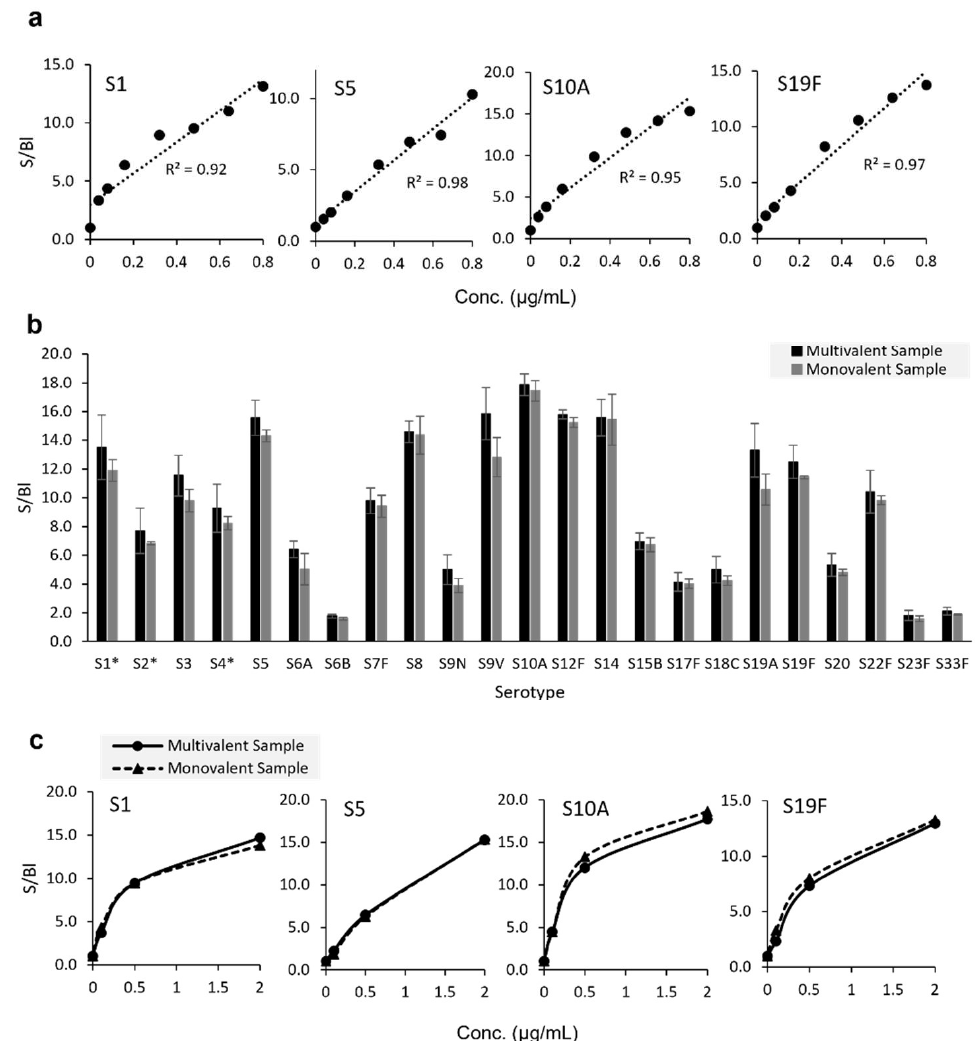
Figure 3. Signal response curves and comparison of response curves for monovalent vs. multivalent analyses. ( a ) Eight-point response curves generated for monovalent native S1, S5, S10A, and S19F labeled using 23-Mix Primary Detection Label. R2 is based on single linear fit (dotted line). ( b ) Signal-to-blank (S/Bl) ratios generated using native PS (ATCC, deposited by Pfizer) at 0.8 µg/mL in contrived 23-valent native polysaccharide mixture and in monovalent form detected by 23-Mix Primary Detection Label. Error bars indicate one standard deviation (n = 3), *: S1, S2, and S4 data are from 400 ms exposure due to signal saturation at 700 ms. ( c ) Response curves were generated using native S1, S5, S10A, and S19F, analyzed monovalently (dotted) and in contrived 23-valent mixture (solid) at 0, 0.1, 0.5, and 2 µg/mL and labeled using 23-Mix Primary Detection Label.